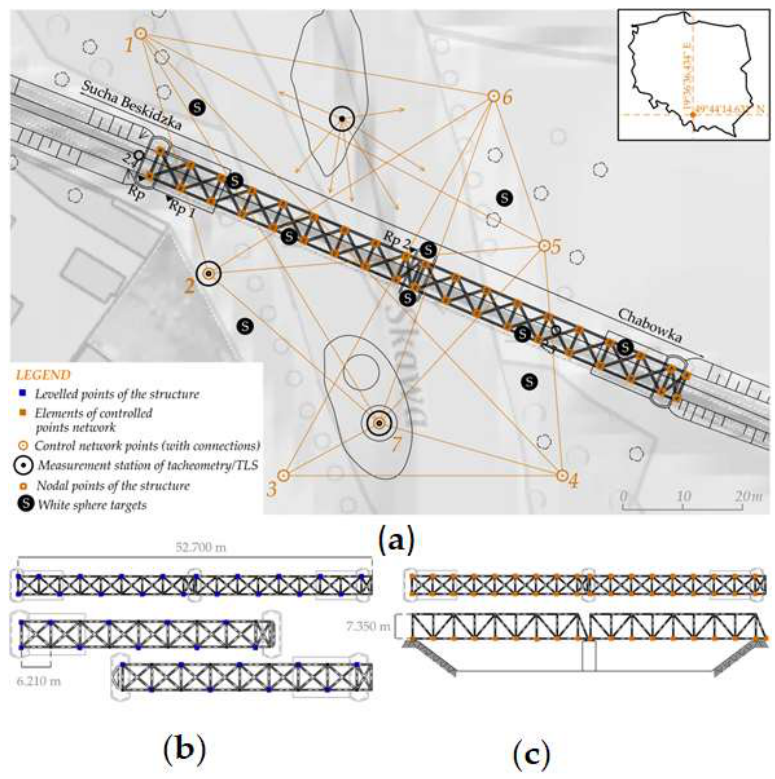
Figure 2. Measurement situations; ( a ) Control network; ( b ) Leveled points of the structure, top view; ( c ) Elements of the controlled point network, top view, back view.